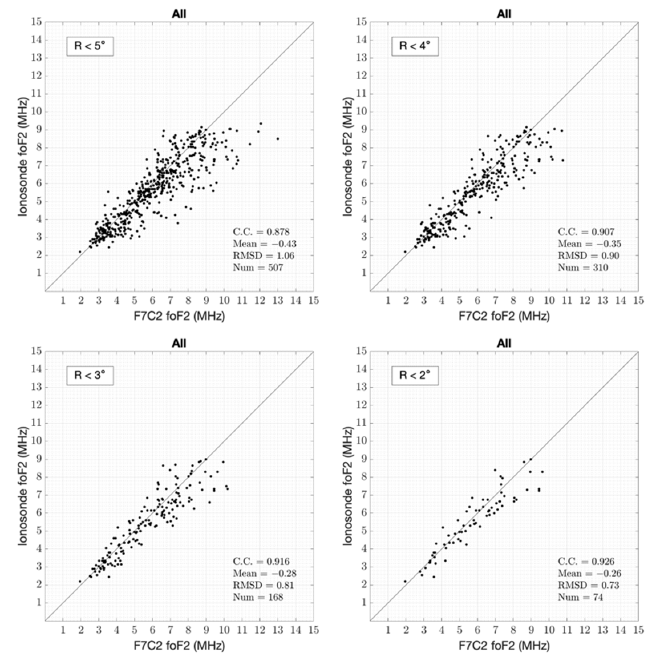
Figure 12. Scatter diagrams of manually scaled foF2 from the ionograms measured by the Chung-Li ionosonde versus FORMOSAT-7 retrieved foF2 using the GPS RO technique for the different spatial coverages with the radiuses centered at the Chung-Li ionosonde station.